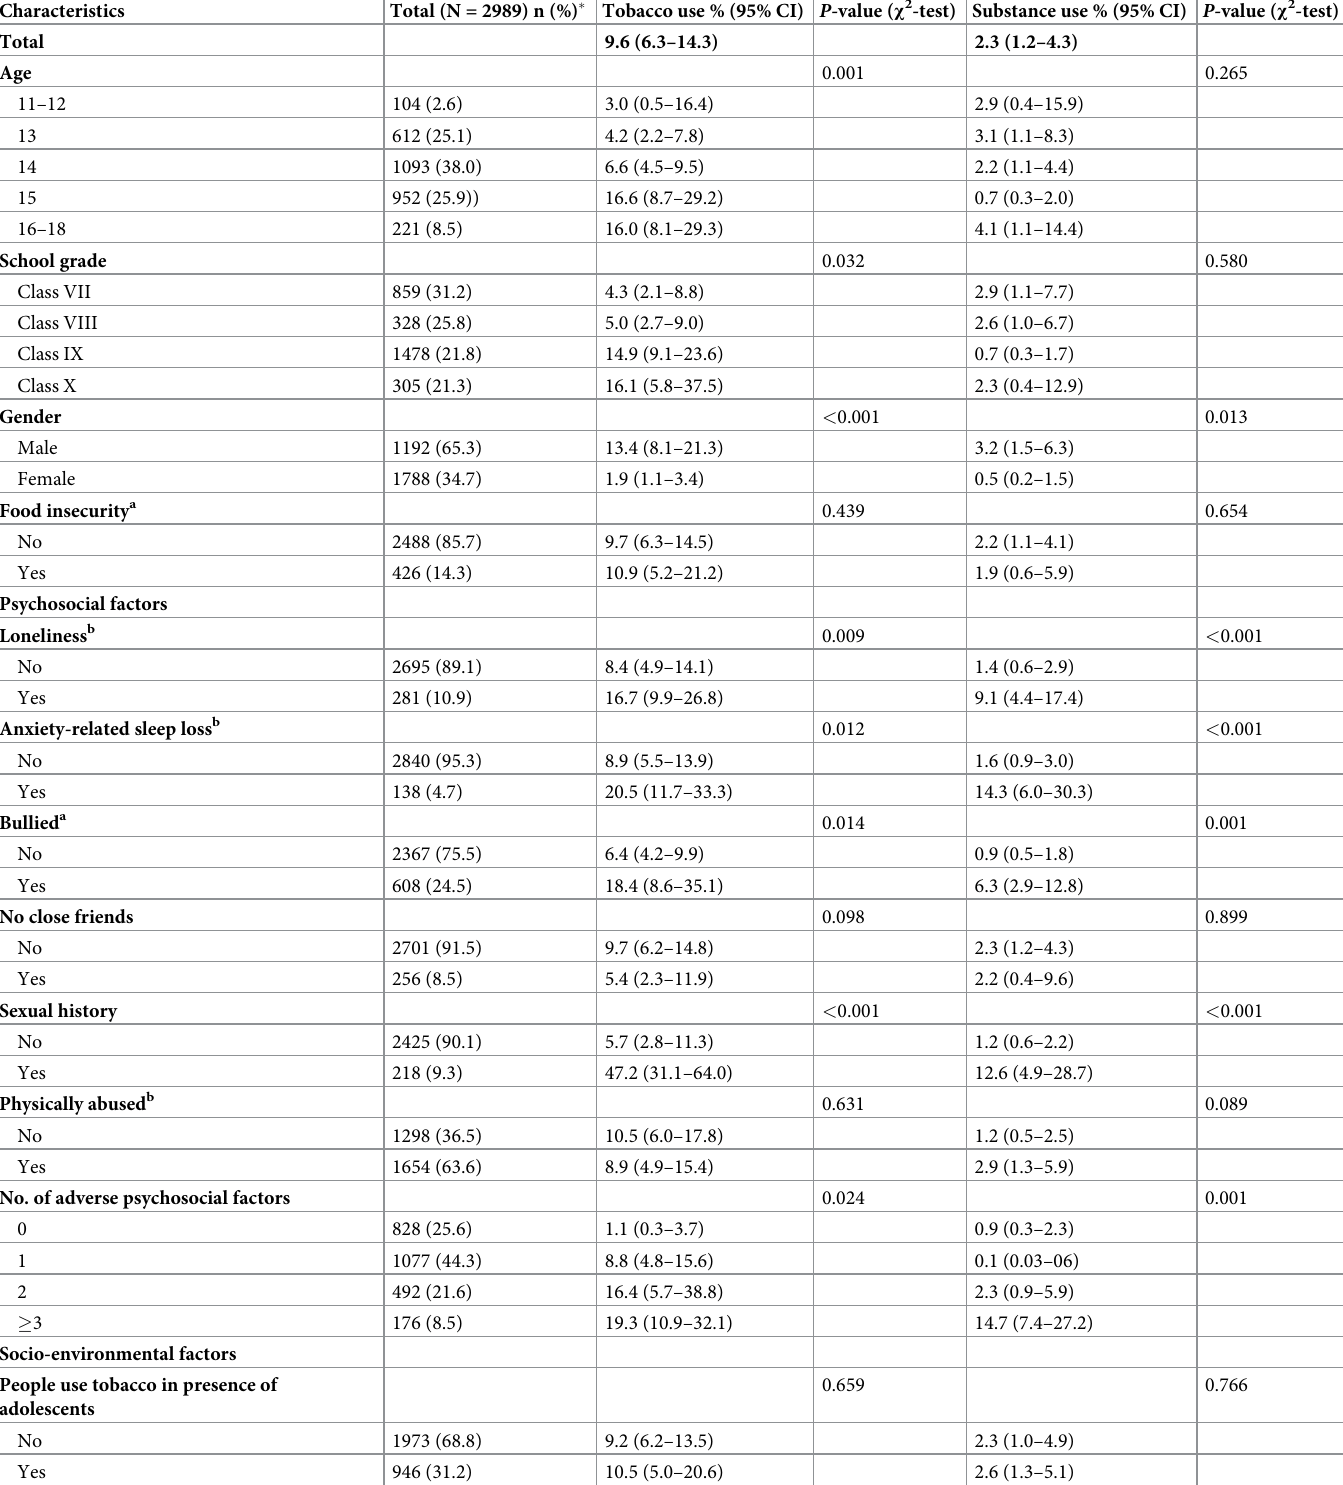
Table 2. Prevalence of tobacco and other substance use according to different socio-demographics and adolescent’s adverse experiences in Bangladesh: Global School-Based Health Survey (GSHS), 2014.